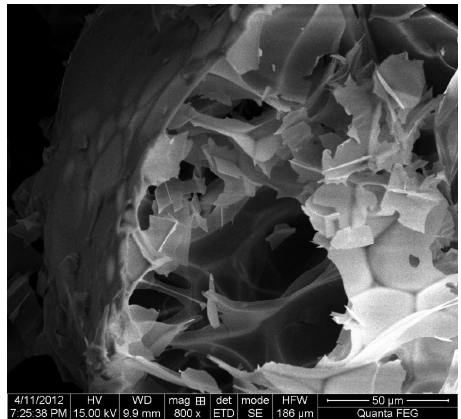
Figure 2 Internal structure of glazed hollow